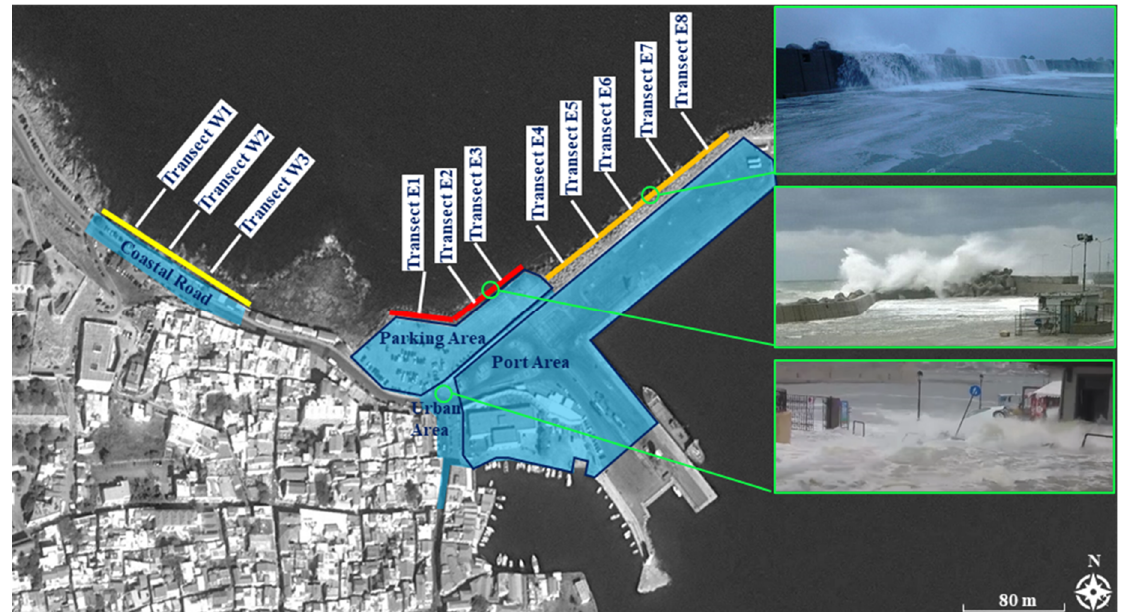
Figure 2. Flood-prone coastal areas of Rethymno. According to the observations, areas highlighted with a transparent light blue color (i.e., the coastal road west of the port, the parking lot, port and urban areas) are susceptible to being inundated by sea water during a storm. The sea–land interface boundaries, from which seawater can penetrate, are highlighted with yellow (in front of the coastal road), red (in front of the parking area) and orange (in front of the port’s windward breakwater) lines. The eleven cross-shore transects (W1–W3 and E1–E8), where the nearshore hydraulic quantities were calculated, are depicted. Photographs illustrate wave overtopping and sea-water flowing over the land area.